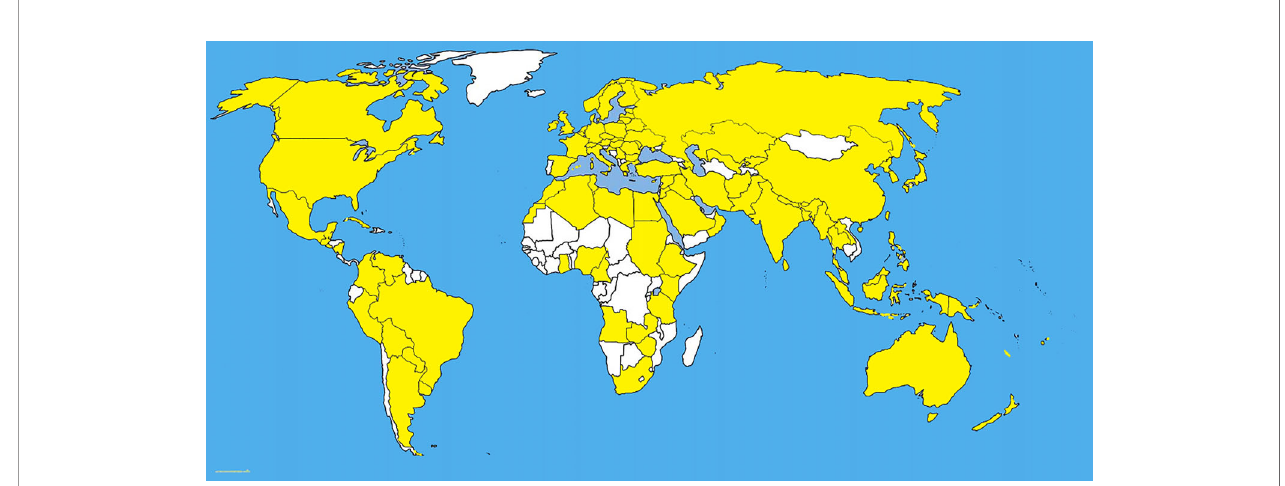
FIGURE 4 | The dIstribution map of Bipolaris sorokiniana . The areas where infection have been reported are indicated in yellow (www.cabi.org/isc. Accessed on 25/03/2021).